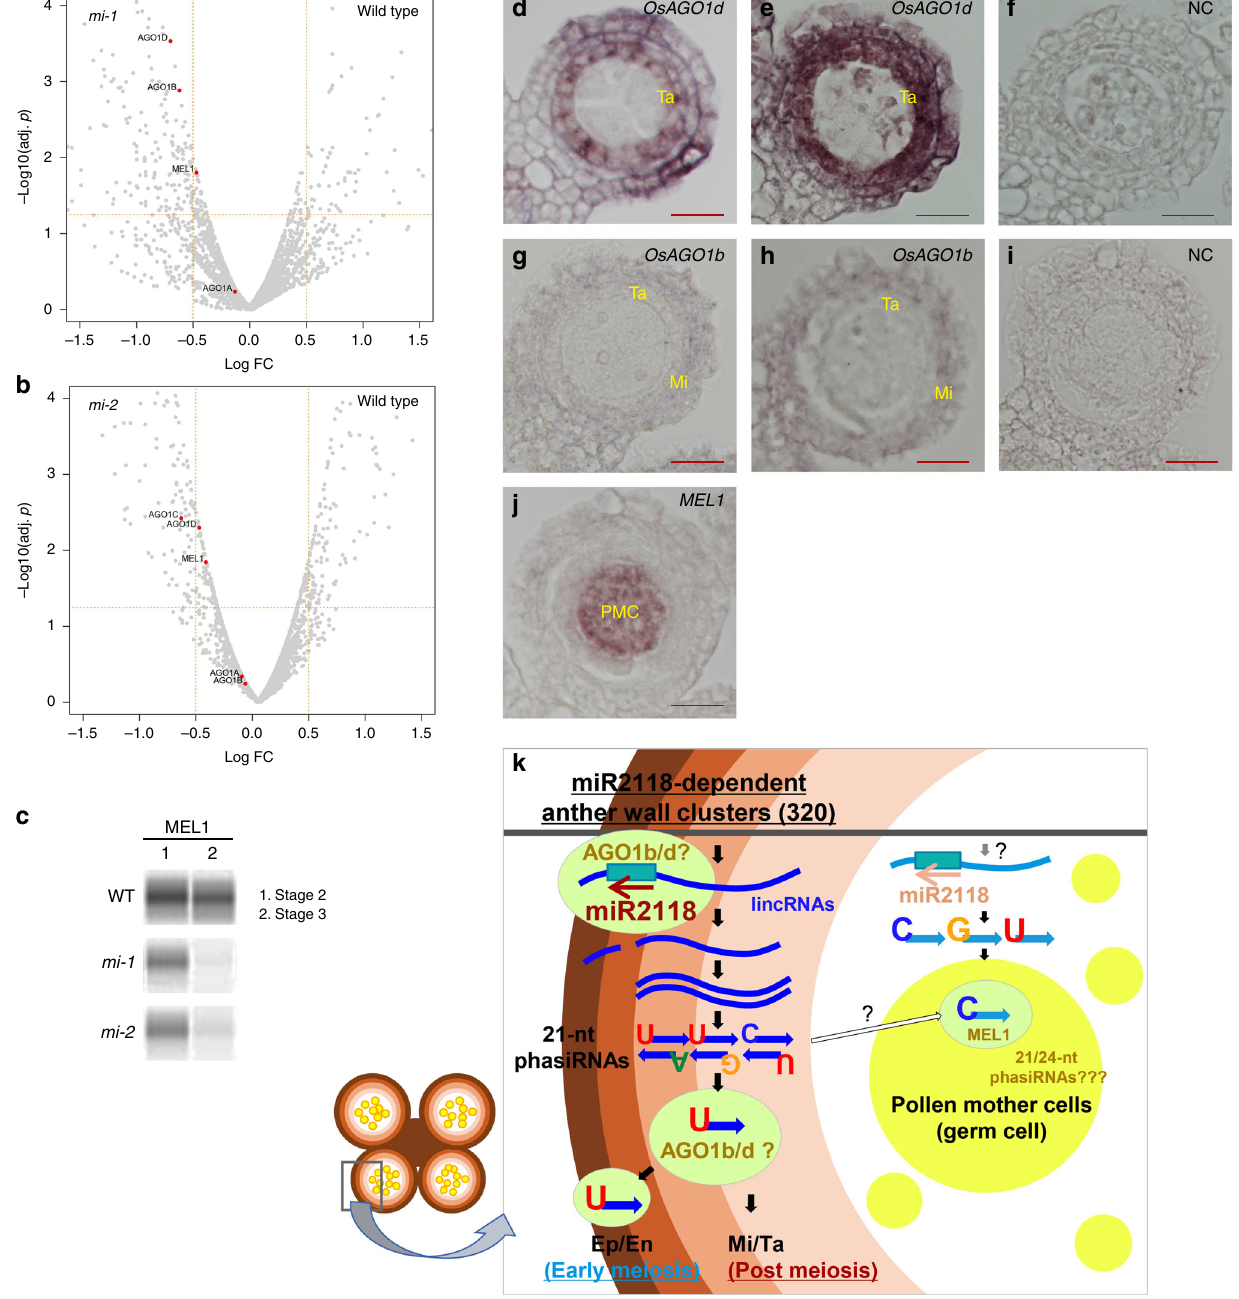
Fig. 6 OsAGO1b/OsAGO1d is highly expressed in the anther wall. a , b Volcano plots of proteome analysis in 0.5 mm anthers (Stage 2) of WT, mi-1 , and mi-2 (WT, three biological replicates; mi-1 and mi-2 , two biological replicates). c Western blot analysis of MEL1 in the anther. Total proteins that were extracted from 0.5 mm anthers (lane 1, Stage 2) and 0.6 mm anthers (lane 2, Stage 3). MEL1 protein is reduced in mi-1 and mi-2 at Stages 2 and 3. d – j In situ hybridization of MEL1 , OsAGO1b , and OsAGO1d in the anther. OsAGO1d expression is abundant in the anther wall, especially at the tapetum (Ta), middle layer (Mi), and endothecium (En) regions. OsAGO1b localization was more enriched in Mi and epidermis (Ep) than Ta. MEL1 is speci fi cally expressed in pollen mother cells (PMC). d , g , j are at Stage 1, and e , h are at Stage 2. NC: Negative controls with the sense strand of OsAGO1d ( f ) and OsAGO1b ( i ) at Stage 2 . Bars = 20 μ m. k Model of cell-linage-speci fi c phasiRNA production during anther development. During early meiosis, miR2118 expression is increased in the epidermis, and promotes the production of 21-nt phasiRNAs in the anther wall. U-phasiRNAs, whose production is dependent on miR2118, may be sorted into OsAGO1. OsAGO1b/d-miR2118 and/or OsAGO1b/d-U-phasiRNAs may function in anther wall development during early meiotic stages. In contrast, in PMC, C-phasiRNAs that interact with MEL1 regulate meiosis progression. After meiosis, miR2118 may further act to regulate the maturation of Ta and